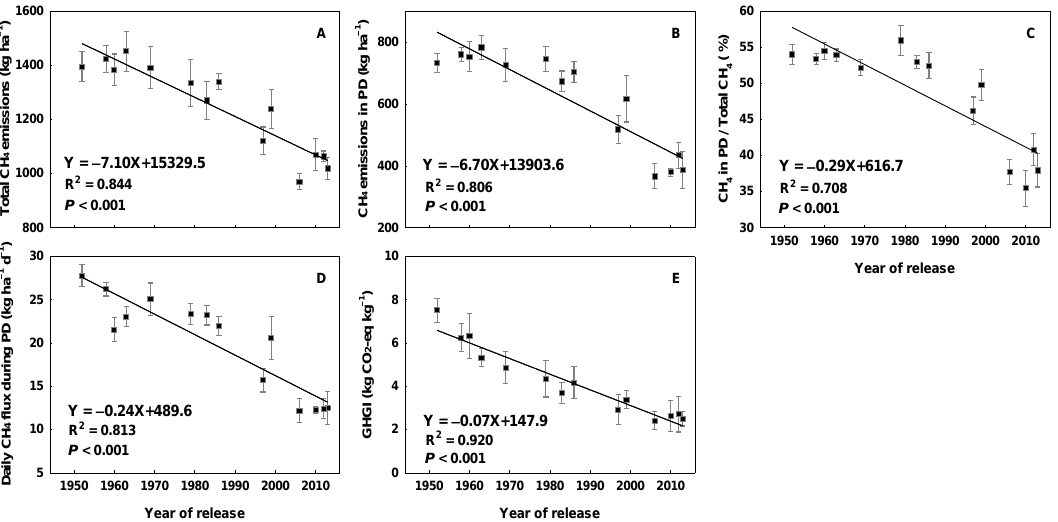
Figure 1. Changes in total CH 4 emissions ( A ), cumulative CH 4 emissions during panicle differentia- tion stage ( B ), the proportion of CH 4 emissions during panicle differentiation in total CH 4 emissions ( C ), daily CH 4 flux during panicle differentiation stage ( D ), and greenhouse gas intensity ( E ) during the japonica rice cultivar renewal. PD: panicle differentiation stage. Solid squares indicate the mean value of two experimental years for each cultivar, and error bars indicate the standard errors of the mean. Solid lines indicate linear regression